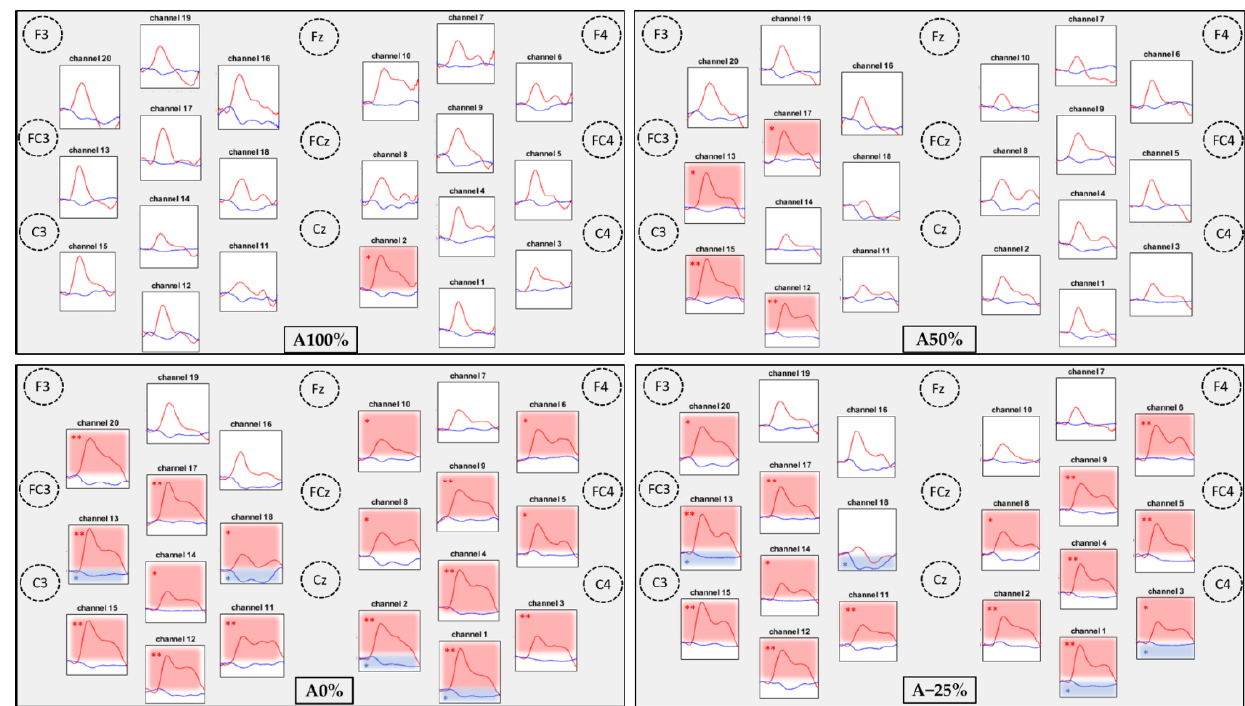
Figure 3. Results of the hemodynamic response by level of assistance (A100%, A50%, A0%, A − 25%) for each channel. The results are expressed by mean (average of the participants). Graph locations were organized according to the anatomical correspondence using the EEG 10/20 system. The time window analyzed was 45 s, from 10 s before the beginning of the task to 35 s after the task. The red traces indicate HbO 2 levels and the blue traces indicate HbR levels. The red boxes indicate a significant difference between rest and task periods for HbO 2 levels. The blue boxes indicate a significant difference between rest and task periods for HbR levels. * p < 0.05 ; ** p < 0.01 (Benjamini – Hochberg correction).